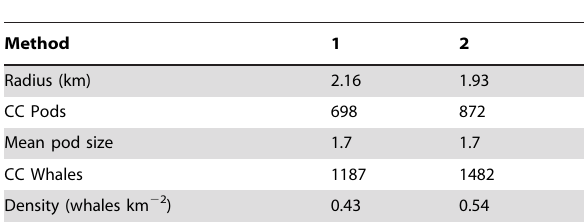
Table 2. The carrying capacity estimates for method 1 (median nearest neighbour) and method 2 (50% of population with a pod within this